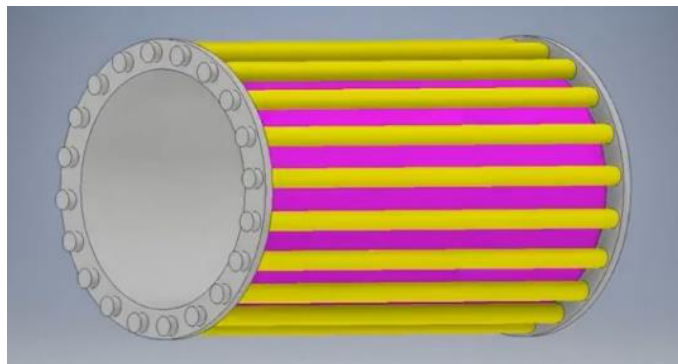
Figure 2. A schematic of the experimental device.